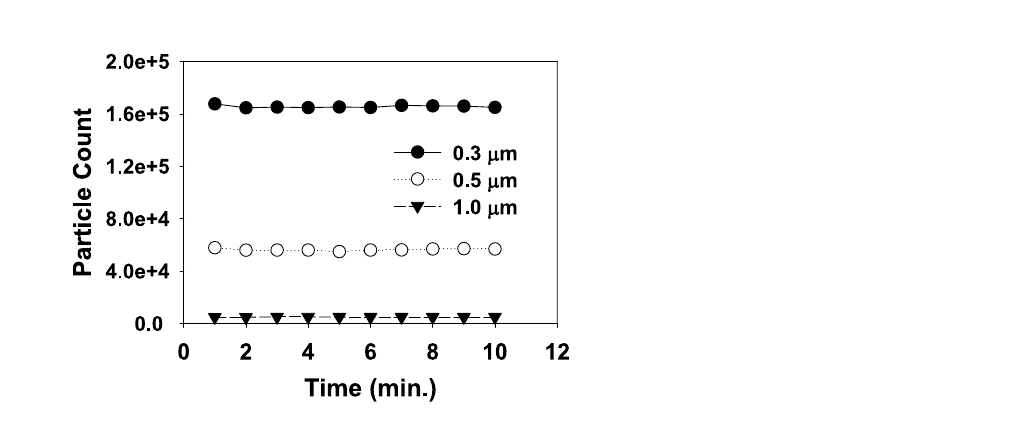
Figure 4. Stability studies of generated NaCl aerosol particle size 0.3, 0.5 and 1